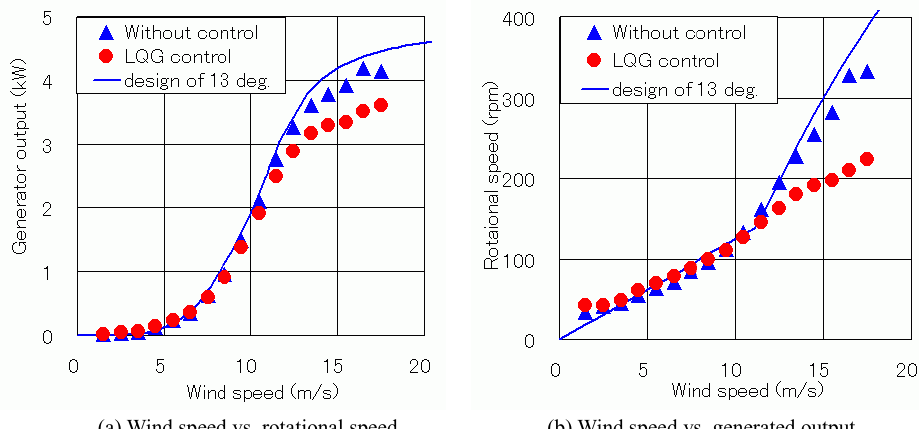
Figure 9 Comparison of with and without pitch control result